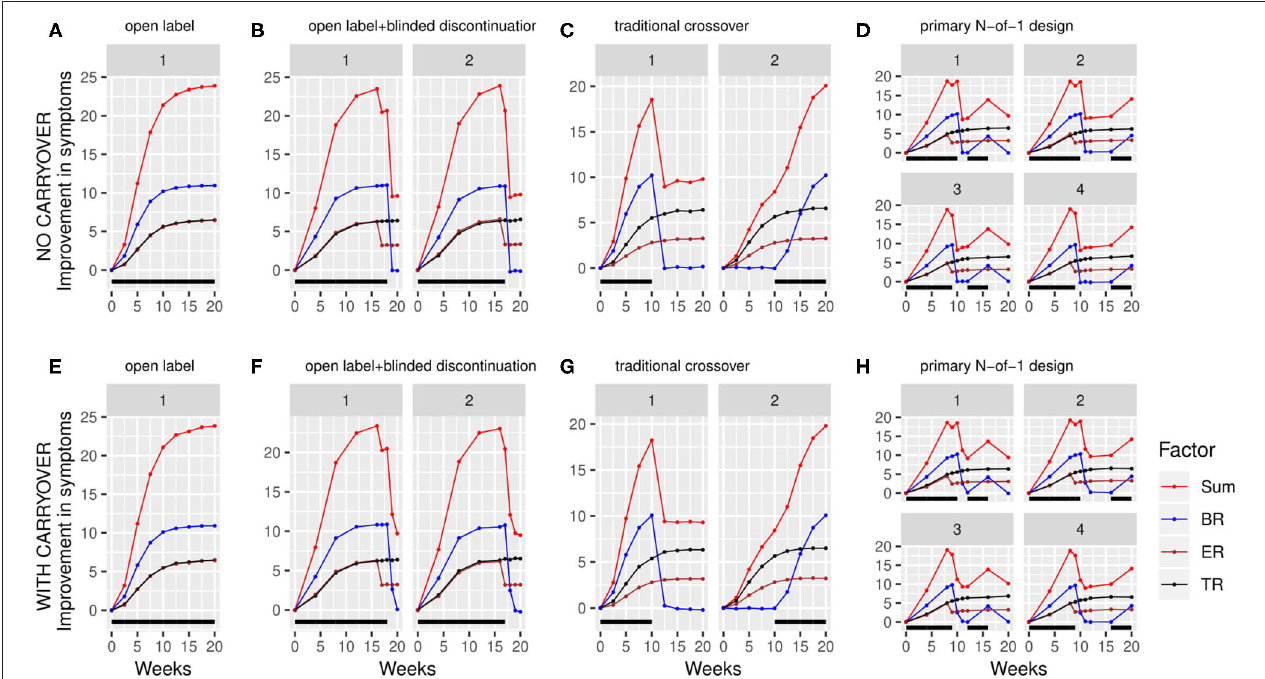
FIGURE 3 | Simulated clinical trials data plotted as change in baseline symptom score as a function of time, broken down by clinical trial design (A–H) and randomization path (numbered facets within each trial design). (A) through (D) show results with carryover set to 0; (E) through (H) show results with carryover set to 0.1 weeks. Individual simulated factors (BR = biologic response to drug, ER = expectancy-related response to drug, and TR = time-varying component unrelated to drug) are shown along with their summed effect. Plotted data represents the averaged output of 500 replicates for each clinical trial design, divided across the number of randomization paths, and was generated using the tabula rasa response parameters. OL = open label, OL + BDC = open label followed by blinded discontinuation, CO = cross over, N-of-1 = proposed N-of-1 trial design. Black bar represents times active drug was scheduled to be